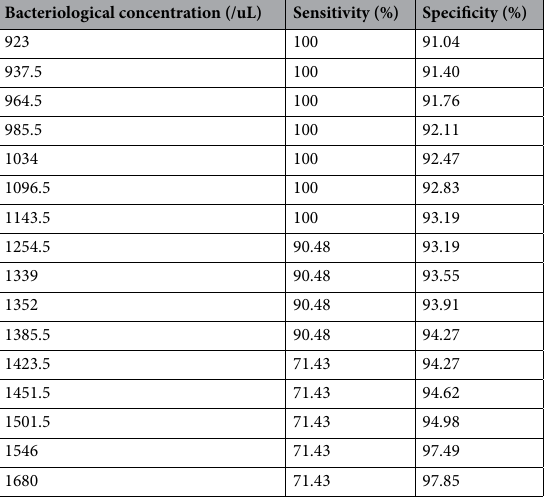
Bacteriological concentration